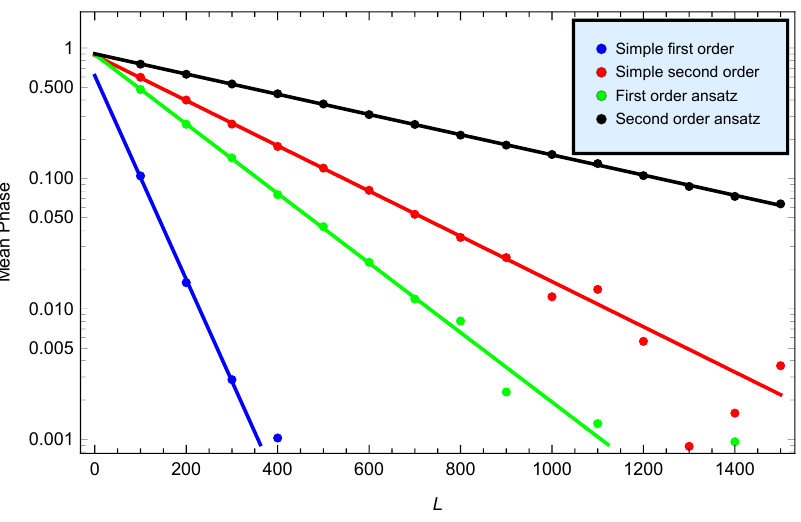
Figure 16 . The mean phase factor as a function of lattice size on a logarithmic scale for the various contours for m = 1 , µ = 1 . The lines are fits to the values at the linear regime. The breaking of the linear (on a logarithmic scale) behaviour is a precursor of the sign